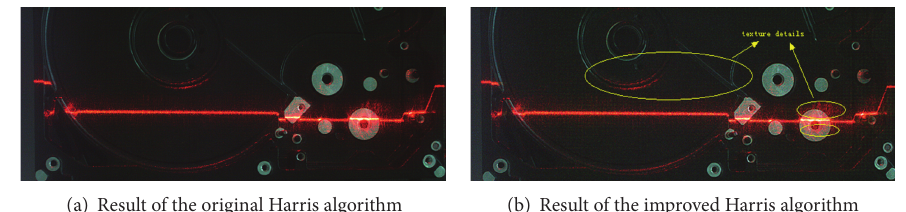
Figure 6: Comparison between the results of the original Harris algorithm and the improved Harris algorithm.